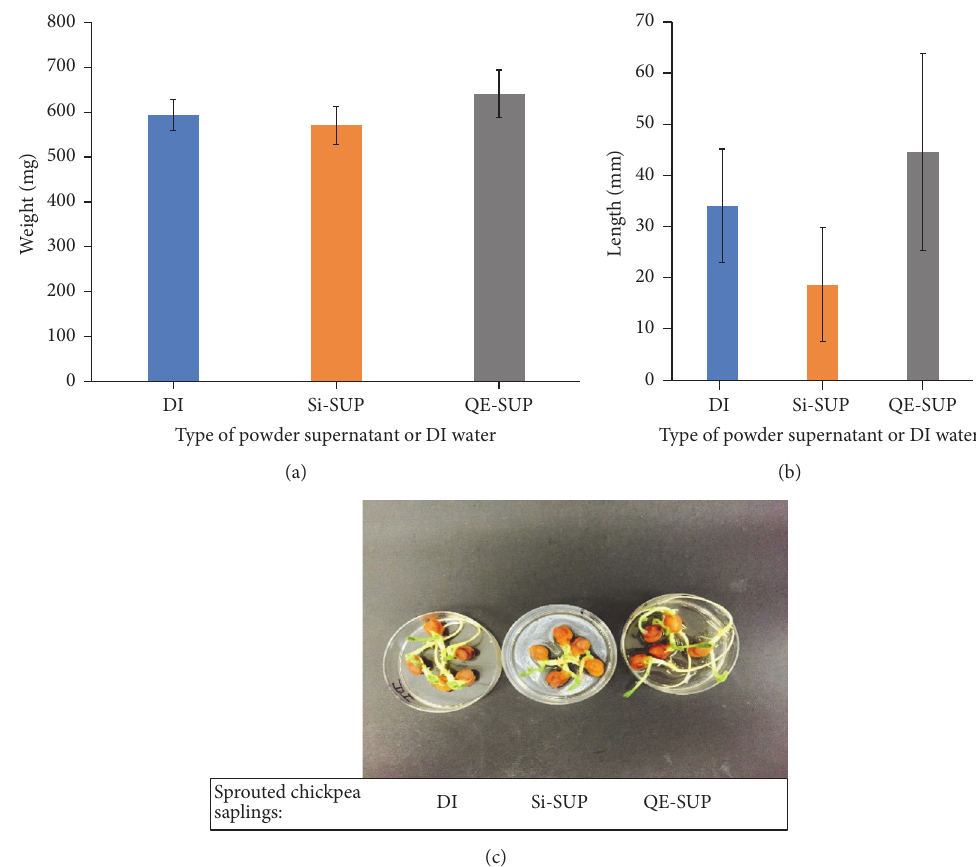
Figure 12: Effect of powder supernatants-QE-SUP or Si-SUP on the (a) weight (mg) and (b) length (mm) of sprouted chickpea saplings after one week ( 𝑛 = 8 seeds). (c) Pictographic representation of the sprouted chickpea saplings in different environments after one week.